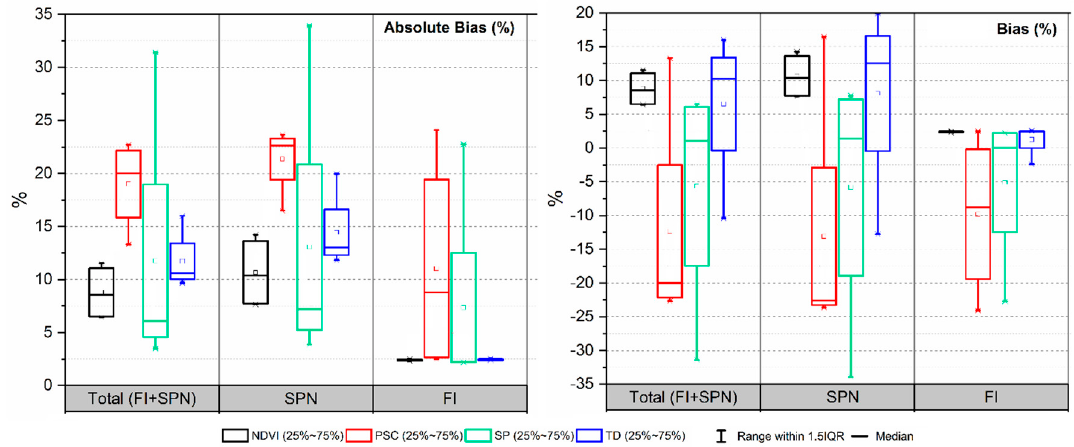
Figure 8. Box plots showing variation in % bias (absolute bias and bias) values pertaining to extracted vegetation from Fisher Island (FI) and Stornes Peninsula (SPN) with reference to vegetated area for four [Target detection (TD), Spectral processing approach (SP), and pixel-wise supervised classification approach (PSC)] practiced feature extraction approaches.